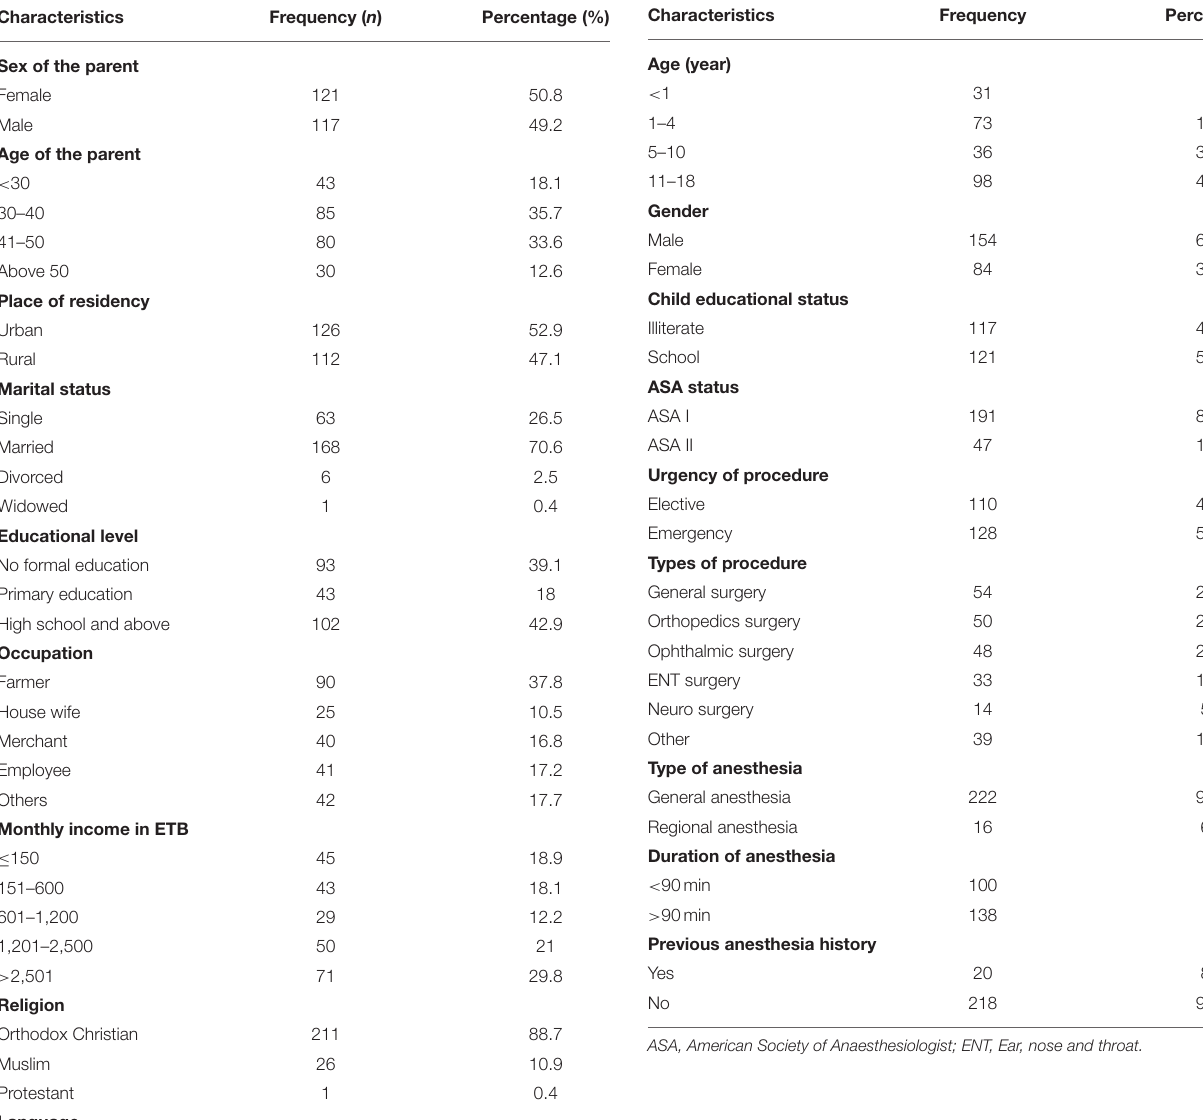
TABLE 2 | Socio-demographic and related characteristics of children, N = 238,